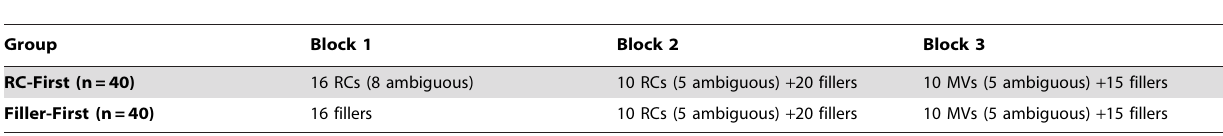
Table 2. Summary of the design and materials used in Experiment 2.